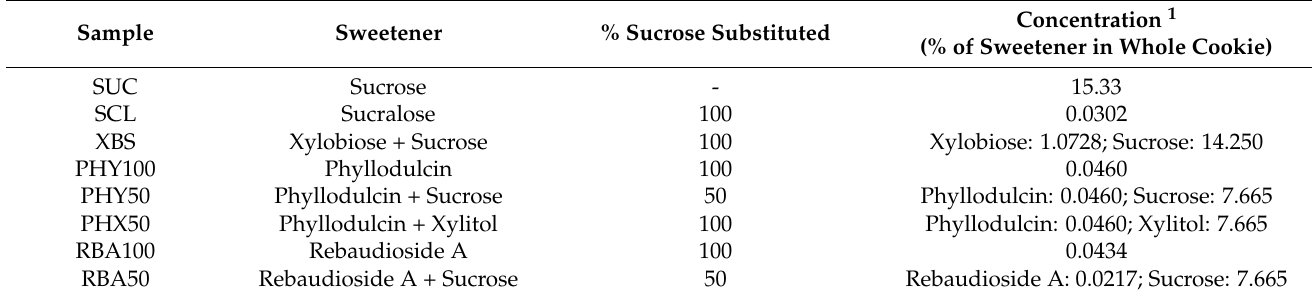
Table 1. Sample information.